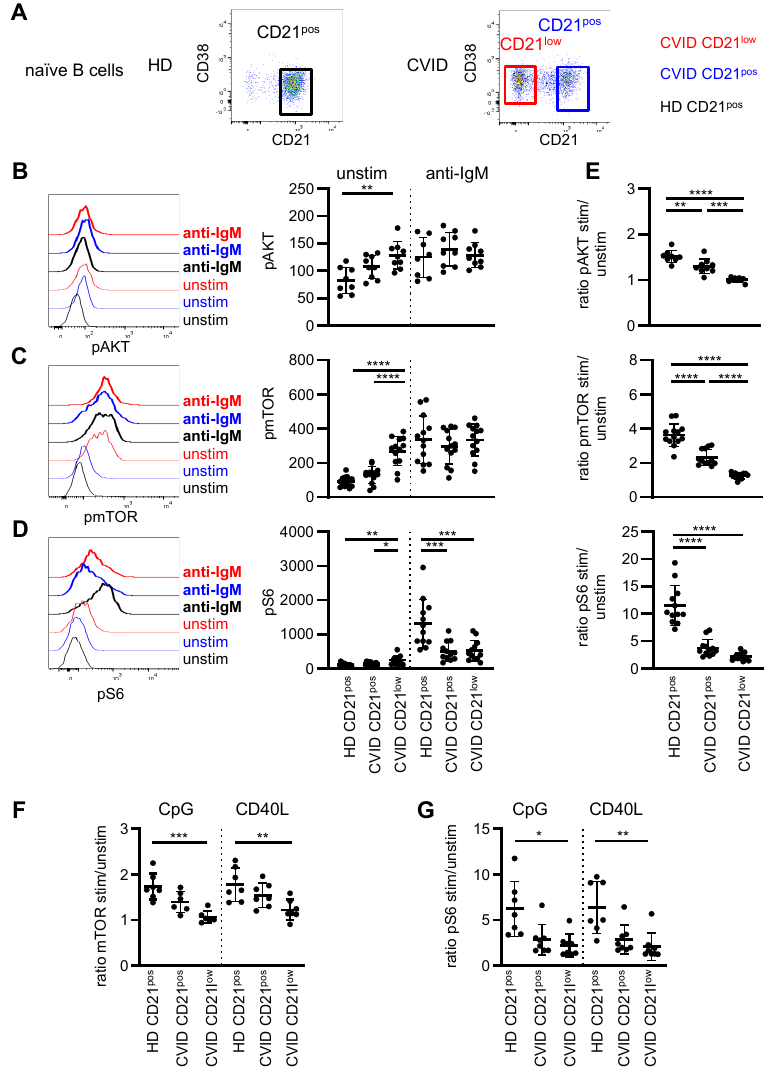
Figure 1. Disturbed phosphorylation of AKT, mTOR and S6 in naïve B cells of CVID patients. ( A ) CD21 pos B cells in one representative HD and CD21 pos and CD21 low B cells in one representative CVID patient as determined by CD21 and CD38 expression after gating on IgM pos CD27 neg CD19 pos B cells. ( B ) Representative histogram of pAKT in populations as described and statistics of the MFI of pAKT unstimulated and after stimulation with anti-IgM for 45 min in CVID patients ( n = 9) and HD ( n = 8). ( C ) Representative histogram and statistics as described in ( A ) for pmTOR ( n = 13) and ( D ) pS6 ( n = 12). ( E ) Ratio of the MFI of pAKT, pmTOR and pS6 after stimulation to unstimulated as shown in ( B – D ). ( F ) Ratio of the MFI of pmTOR and ( G ) pS6 stimulated with CpG or CD40L to unstimulated in CD21 pos B cells of HD and CD21 pos and CD21 low B cells from CVID patients ( n = 7–8). * p < 0.05, ** p < 0.01, *** p < 0.001, **** p <